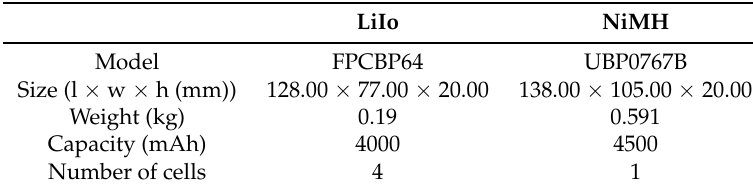
Table 2. Specifications of the LiIo and NiMH batteries [22].